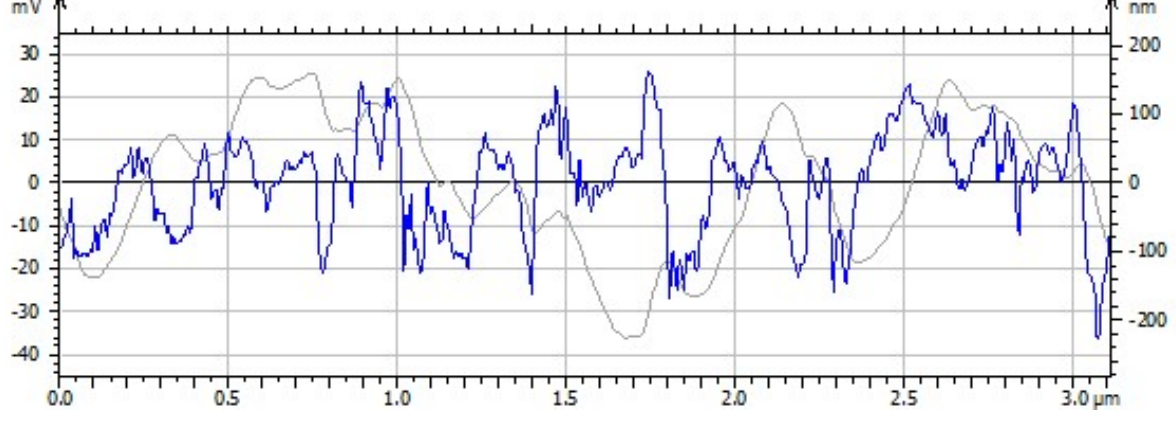
Figure 5. Roughness profile of TiO 2 scaffolds.